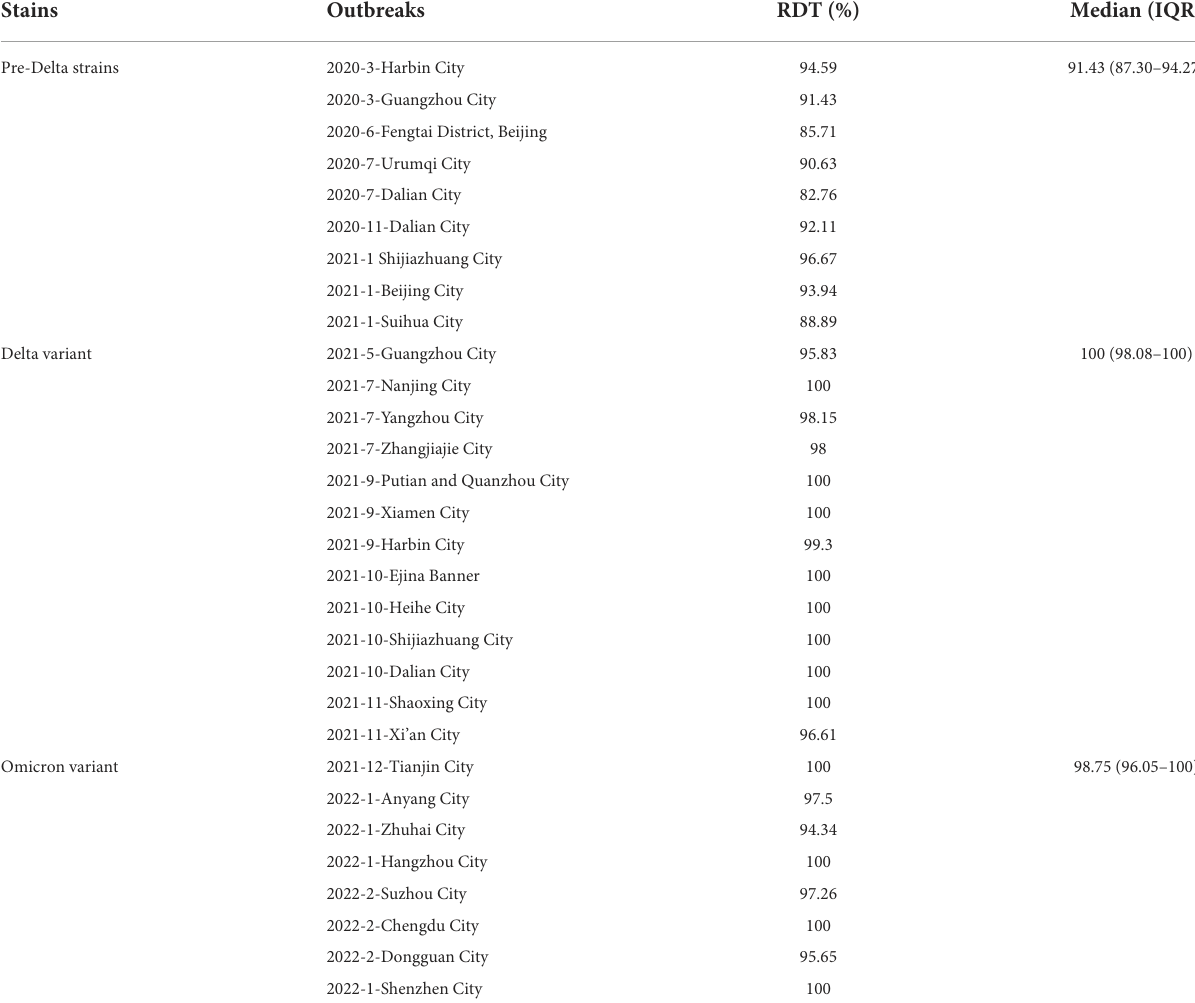
TABLE 3 The RDT of nine pre-Delta strains, 13 Delta variant and eight Omicron variant outbreaks.